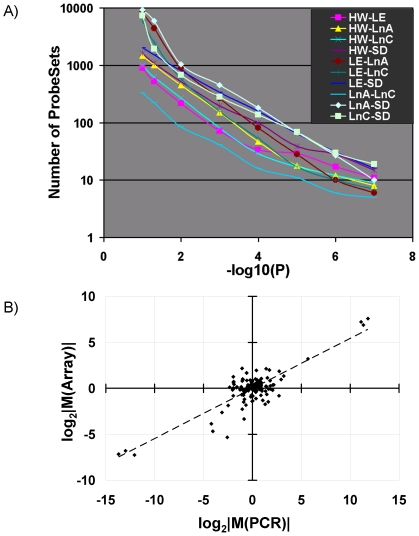
Pair-Wise Comparisons of Rat Strains/Lines.A) Linear-modelling was used to identify differentially-expressed ProbeSets between all ten pairs of rat strains/lines. The number of ProbeSets differentially expressed for each pair (y-axis) is plotted as a function of the P-value threshold (x-axis). The ranking of different pairs remains consistent, independent of the threshold selected. B) To validate our analysis 21 genes were also assessed using gold-standard real-time RT-PCR. For each gene all pair-wise comparisons were made and the fold-changes calculated. This led to 131 comparisons that were made by both RT-PCR and microarray. When these are plotted in log2-space it is clear that the two assays yield highly correlated measurements (Pearson's R = 0.839; p<2.2×10−16).